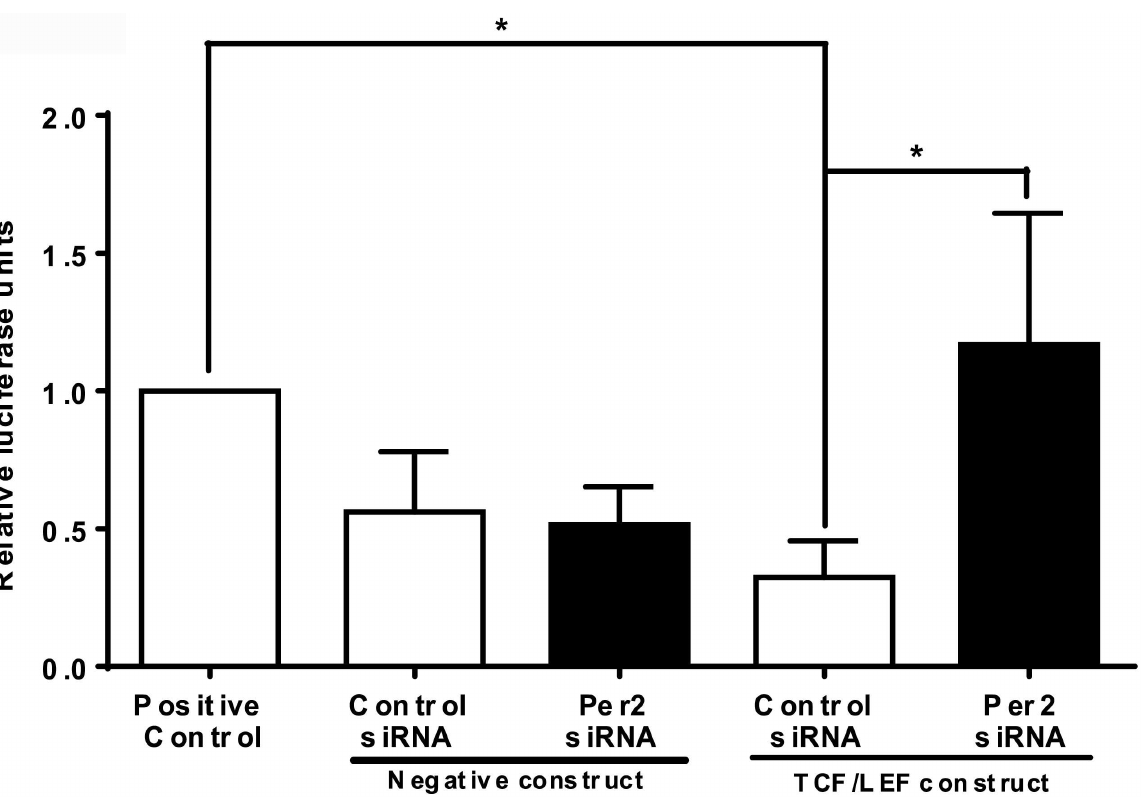
Fig 6. β -catenin binds to TCF/LEF factors after treatment with siRNA Per2 . The TOPflash assay was performed to study the nuclear bindingof β -catenin after treatment with siRNA Per2 . The bar chart showinga significant increase in luciferase signal followinga treatment with siRNA Per2 when comparedto a control siRNA. n = 3, * p < 0.05.